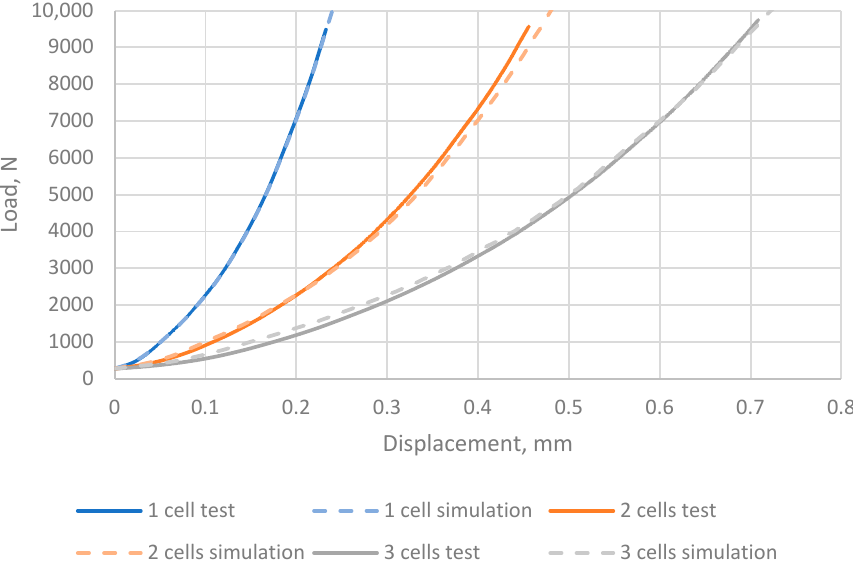
Figure 8. Comparison of lateral compression for stacks of 1, 2 and 3 cells.